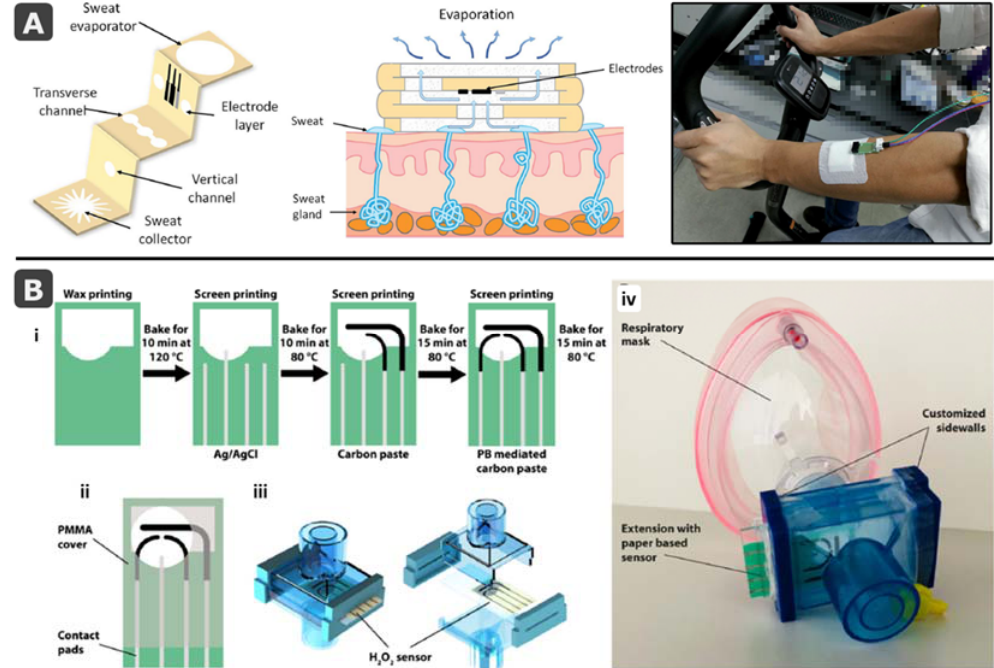
Figure 7. ( A ) Schematic diagram of the 3D microfluidic device developed by Cao et al. for sweat analysis. Schematic representation of the device applied on skin; a channel was formed by folding the origami device through which the sweat flow from the skin to the electrochemical cell. Picture of the device applied on the forearm of a user. Reproduced from [158] with permission from The Royal Society of Chemistry. ( B ) Schematics of the procedure of fabrication and the final design of the screen ‐ printed electrochemical cell inserted in the mask developed by Maier et al. ( i and ii ). Model of the customized filter extension in which the screen ‐ printed electrochemical cell is inserted ( iii ). Photograph of the respiratory mask with the filter extension containing the screen ‐ printed electrode ( iv ) Reproduced from [167] (open access).